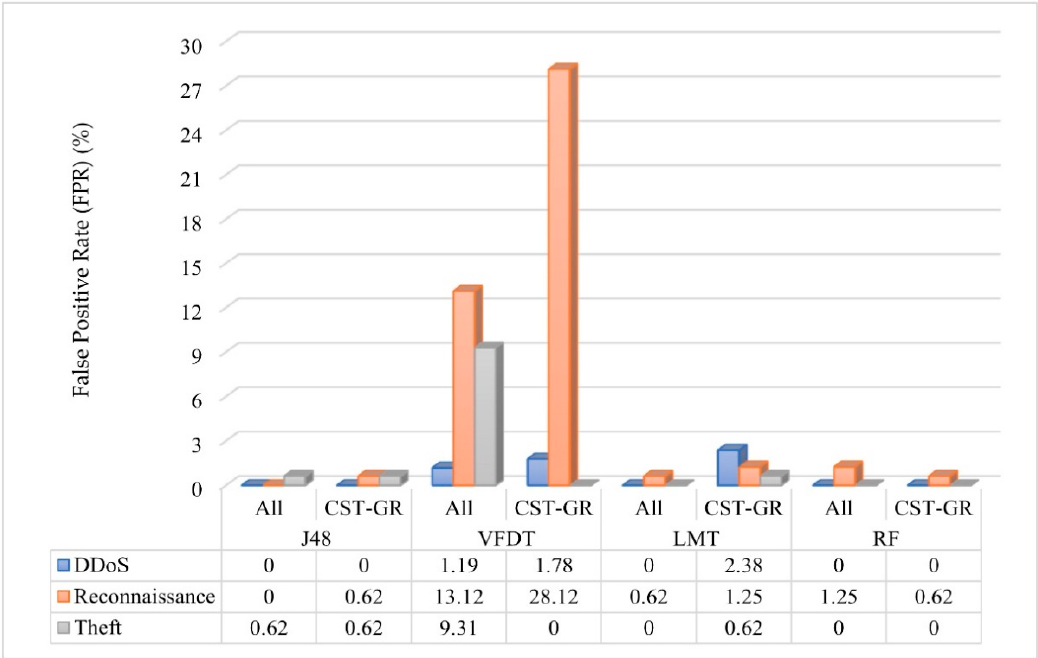
Figure 5. A comparison of FPR of J48, VFDT, LMT, and RF between the cases using all features and using CST-GR selected features for each kind of attack.